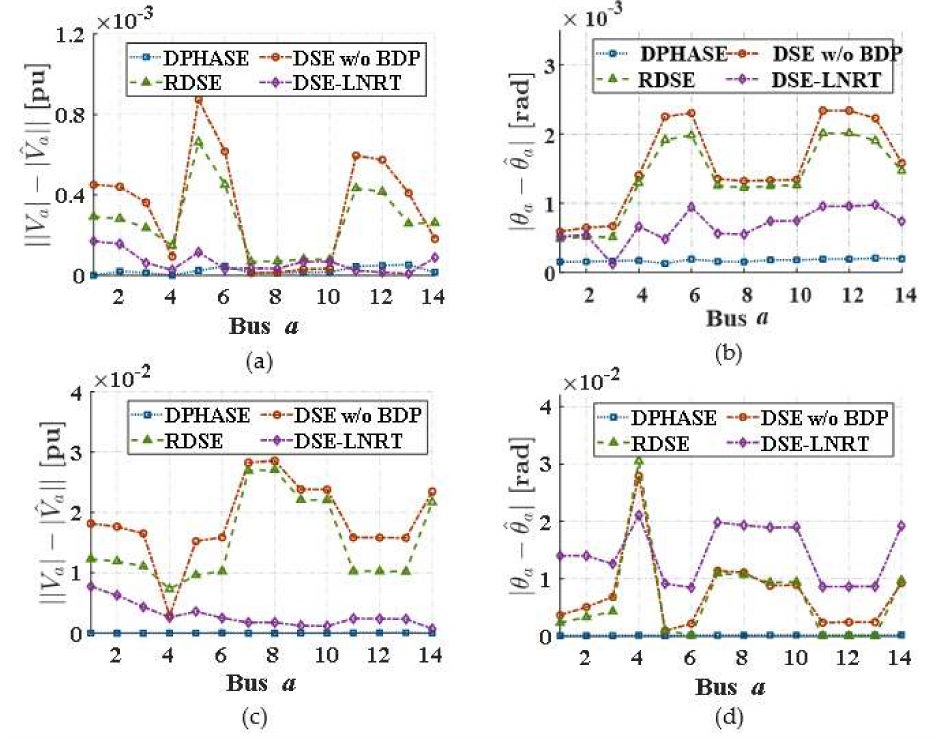
Figure 17. Comparison of absolute SE errors: ( a , b ) voltage magnitudes and phase angles for the BD in the SCADA measurements and ( c , d ) voltage magnitudes and phase angles for the BD in the PMU